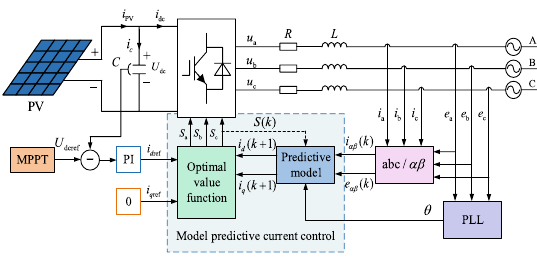
Fig. 10 FCS-MPCC control structure of the PV inverter